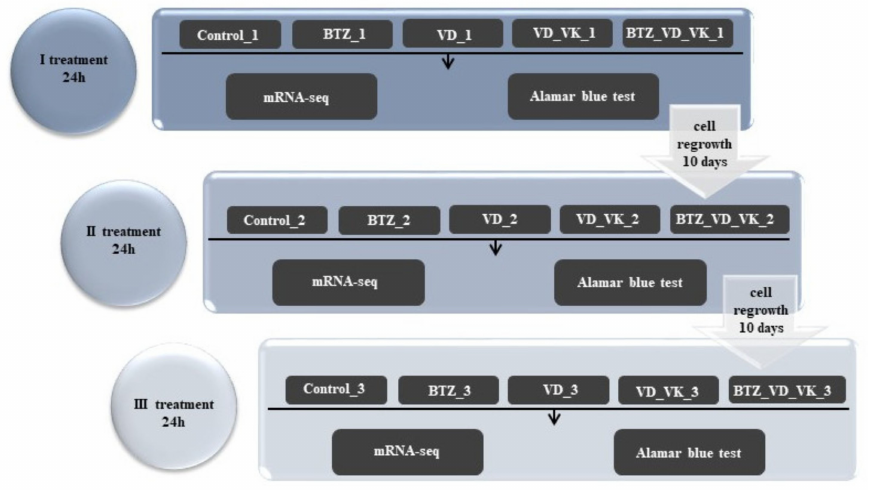
Figure 1. Scheme of